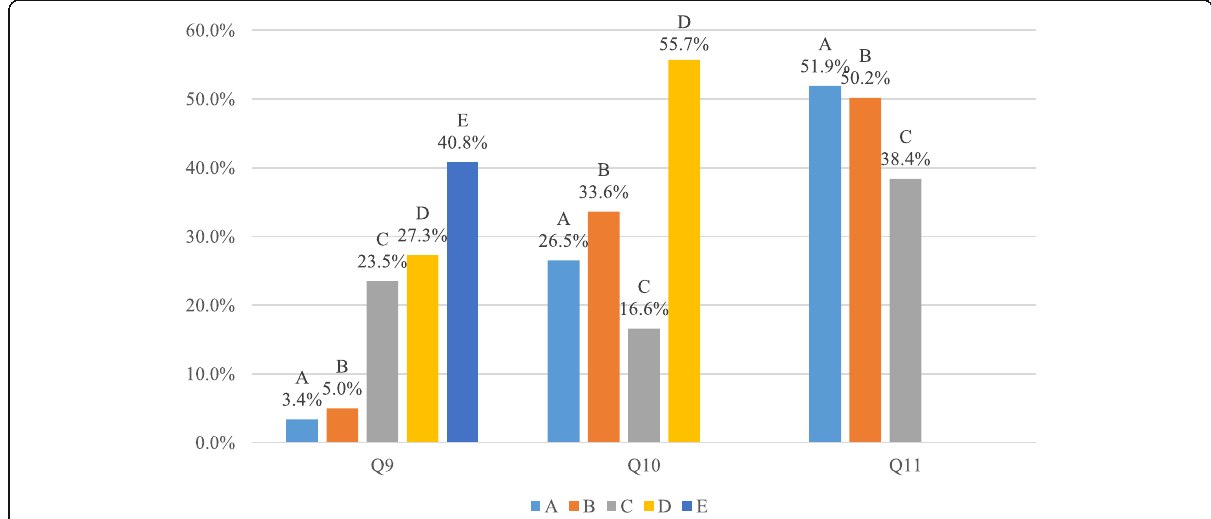
Fig. 3 Descriptive statistics of Q9-Q 11. Note: Appendix 1 contains details of the questions and